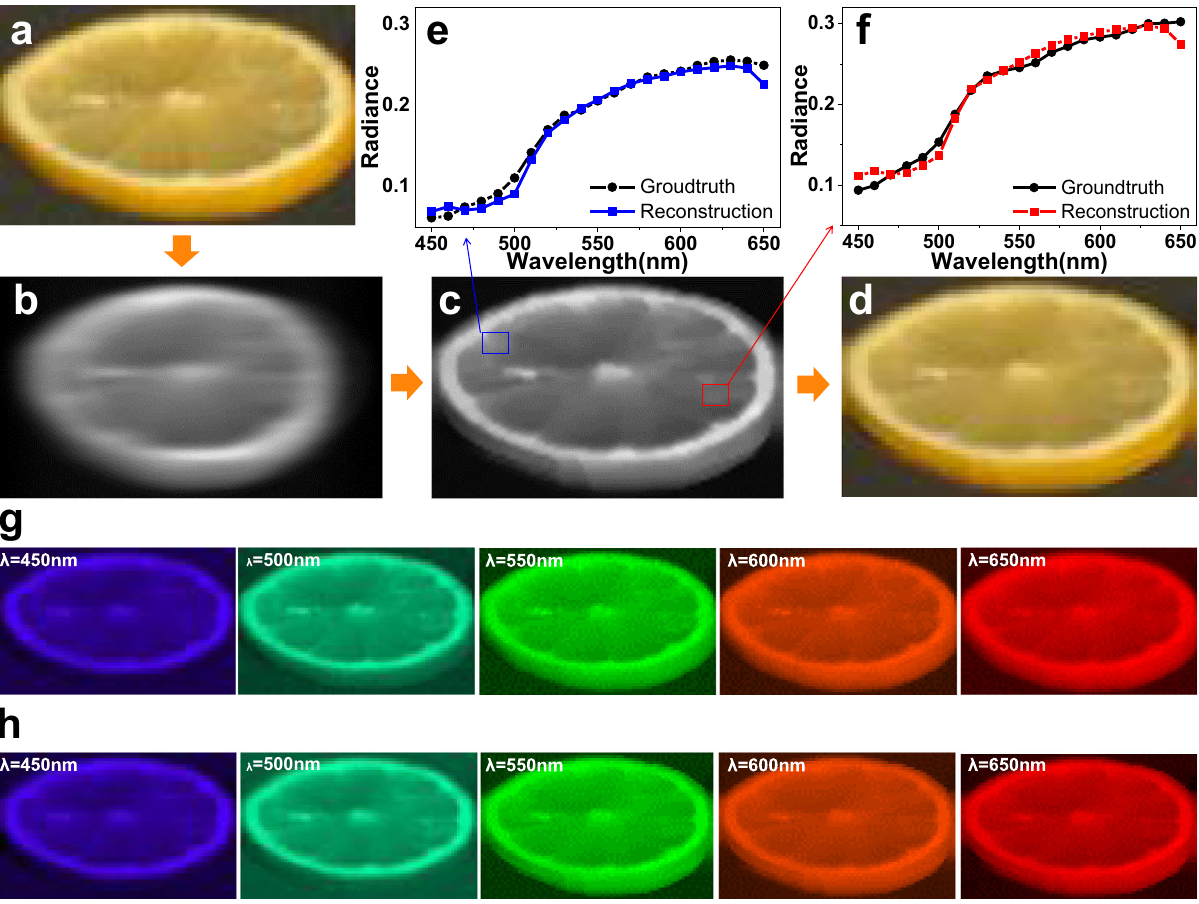
Fig. 3 Numerical simulation results of spectral reconstruction algorithm for SLIM. a The original RGB image of spectral data. b The simulated dispersion image using the forward model same as SLIM. c The reconstructed gray image. d The reconstructed color image synthesis from reconstructed spectral data. e The spectral plot of green position, the green line is reconstructed result, the black line is ground truth. f The spectral plot of blue position, the blue line is the reconstructed result, the black line is the ground truth. g The original single wavelength images are presented. h The reconstructed single wavelength images are